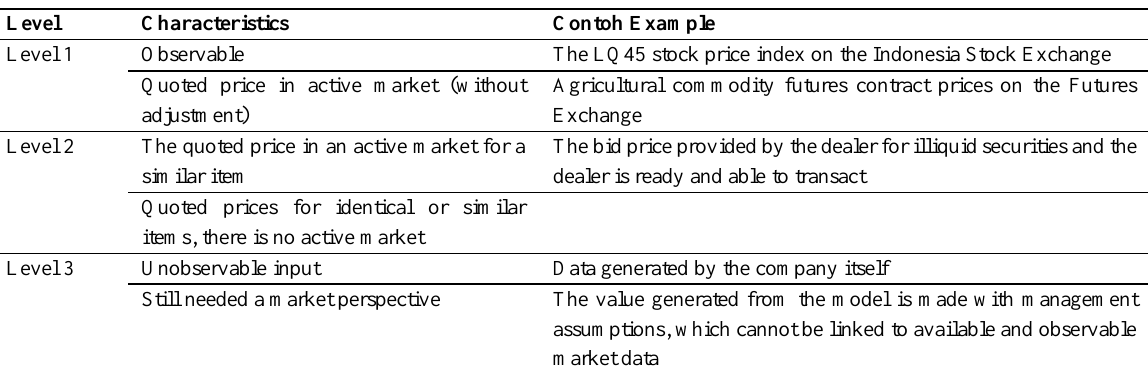
Table 2: Fair Value